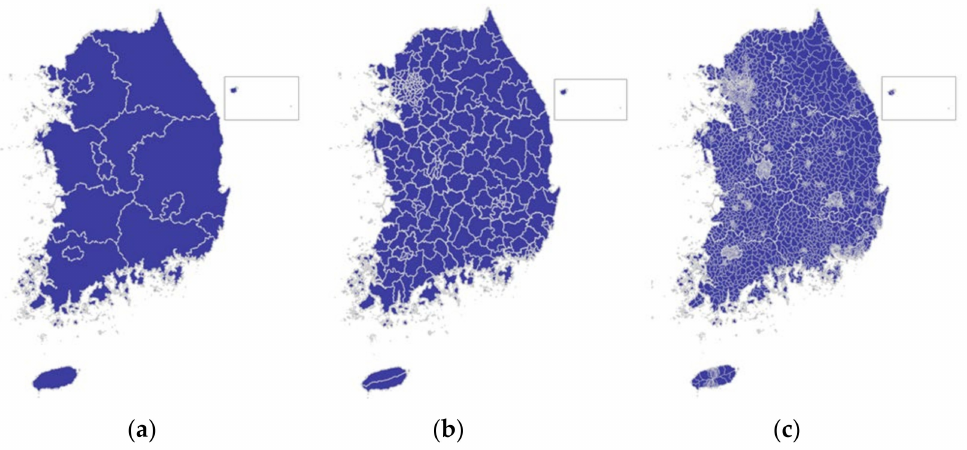
Figure 1. Administrative divisions of South Korea [5]: ( a ) Principal level: special city, metropolitan city, province; ( b ) municipal level: city, county, and district; ( c ) sub-municipal level: town, township, and